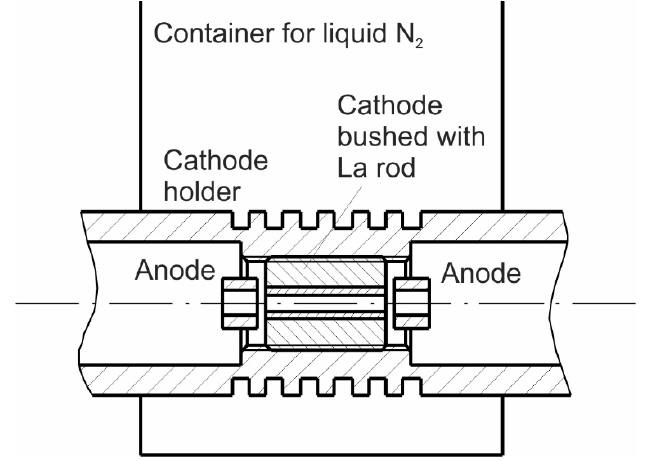
Figure 1. Sketch of the hollow cathode lamp. The ceramic anode holders and the connecting pins are not shown. The cathode holder is grounded. Length of the cathode is 20 mm. not shown. The cathode holder is grounded. Length of the cathode is 20